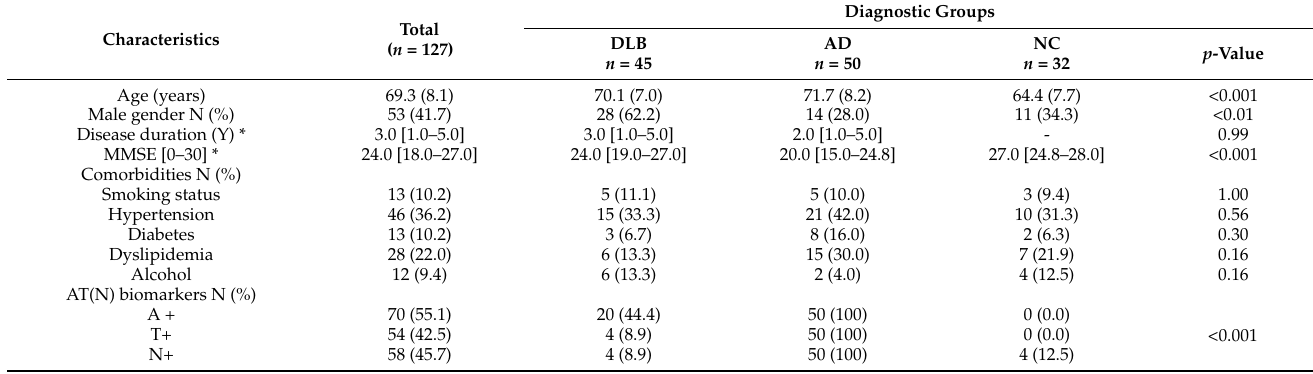
Table 1. Clinical and biological characteristics of the study